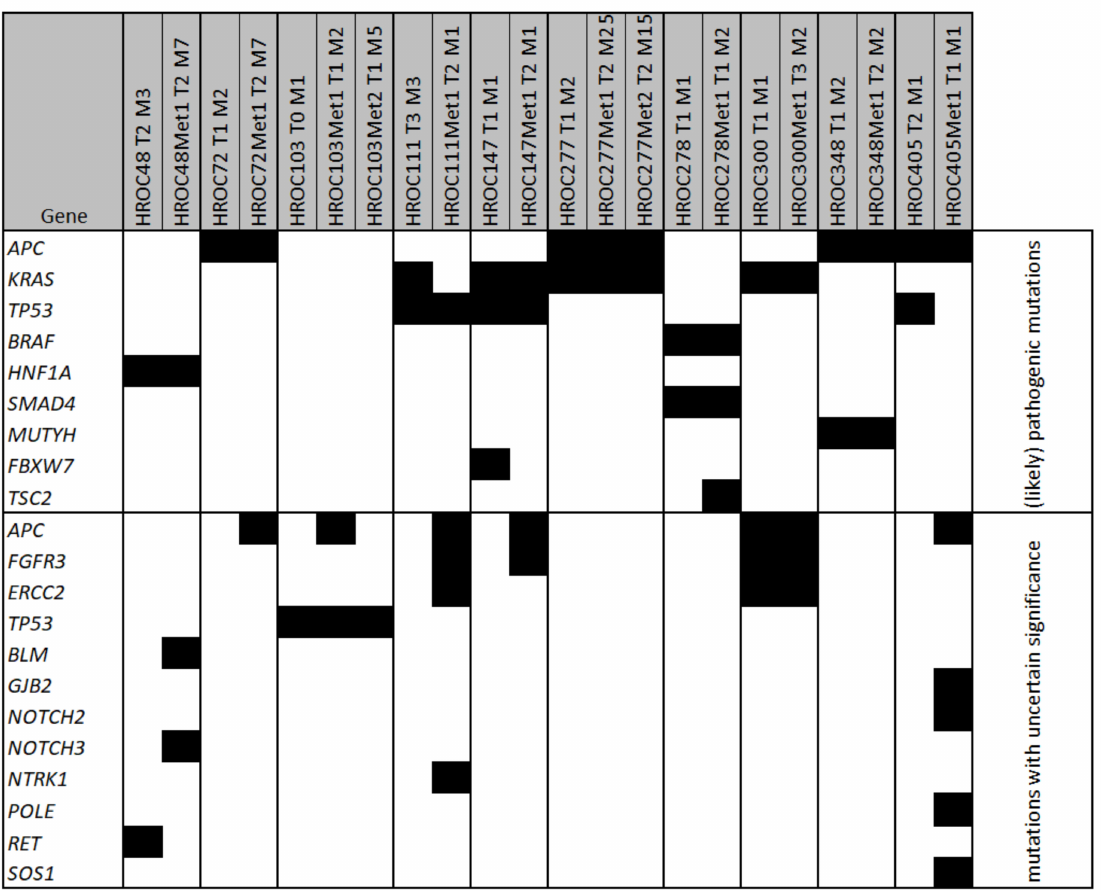
Figure 1. Mutated genes in samples of patient-derived xenografts. Depicted are the genes with ≥ 1 detected mutation (marked as black boxes) in the Solid Tumour Panel consisting of 105 fully sequenced genes plus mutational hot spots from additional 146 genes with an allele frequency ≥ 25. Xenograft names consist of patient ID (HROCxxx), number of transfers (Tx) and mouse identifier